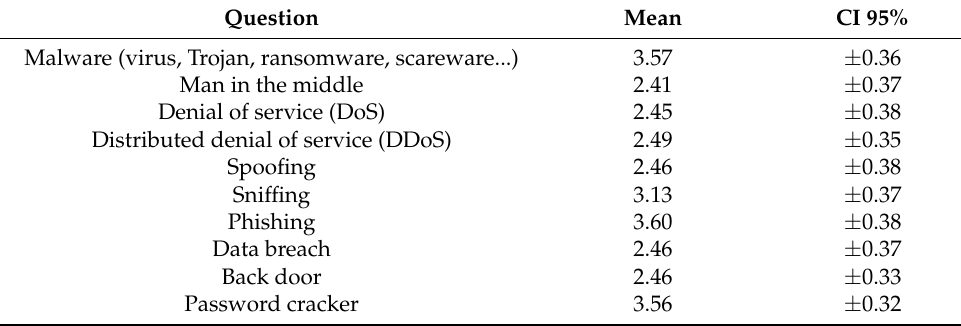
Table 5. Assessed knowledge on cybersecurity.